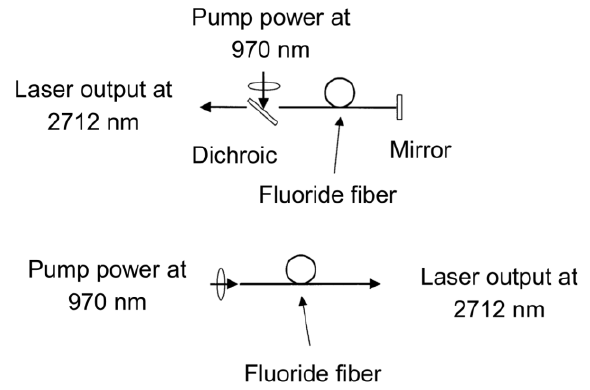
Figure 4. Set-ups of the two fiber laser configurations demonstrated in [25]. Figure adapted from [25].